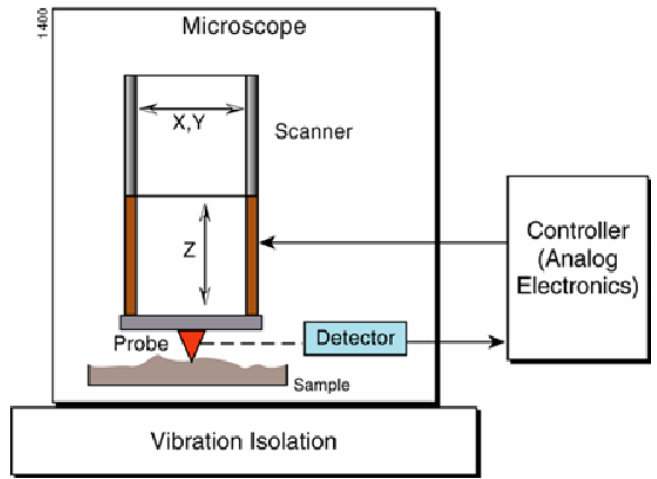
Figure 2. Basic tip movements in atomic force microscopy (AFM) [14].